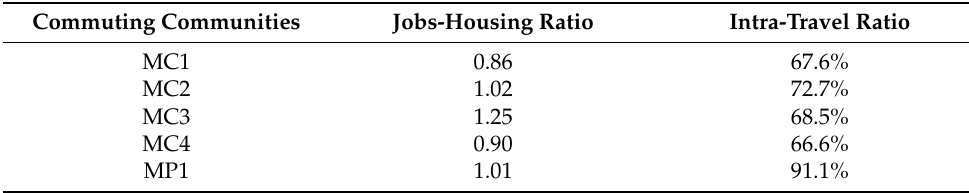
Table 5. The jobs–housing ratio and the intra-travel ratio of commuting communities in Tianjin metropolitan area.